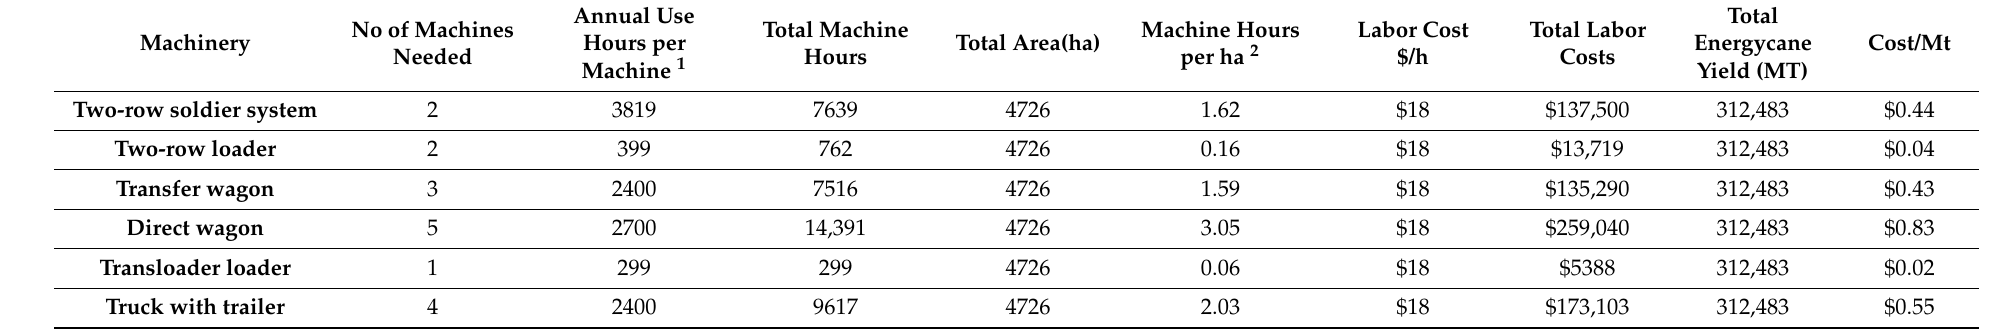
Table 7. Total labor costs for harvesting and transportation unit.